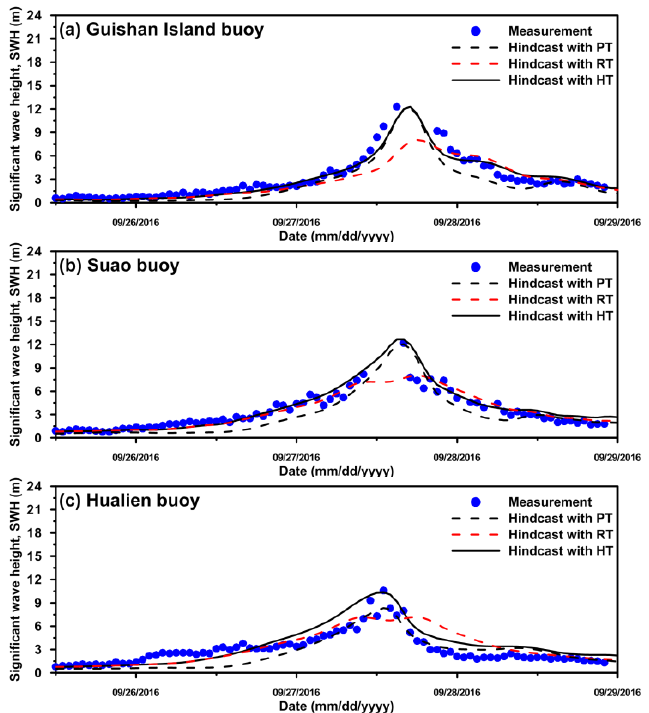
Figure 10. Comparison of the significant wave height (SWH) between model predictions and measurements at the ( a ) Guishan Island, ( b ) Suao, and ( c ) Hualien buoys for Typhoon Megi (2016).